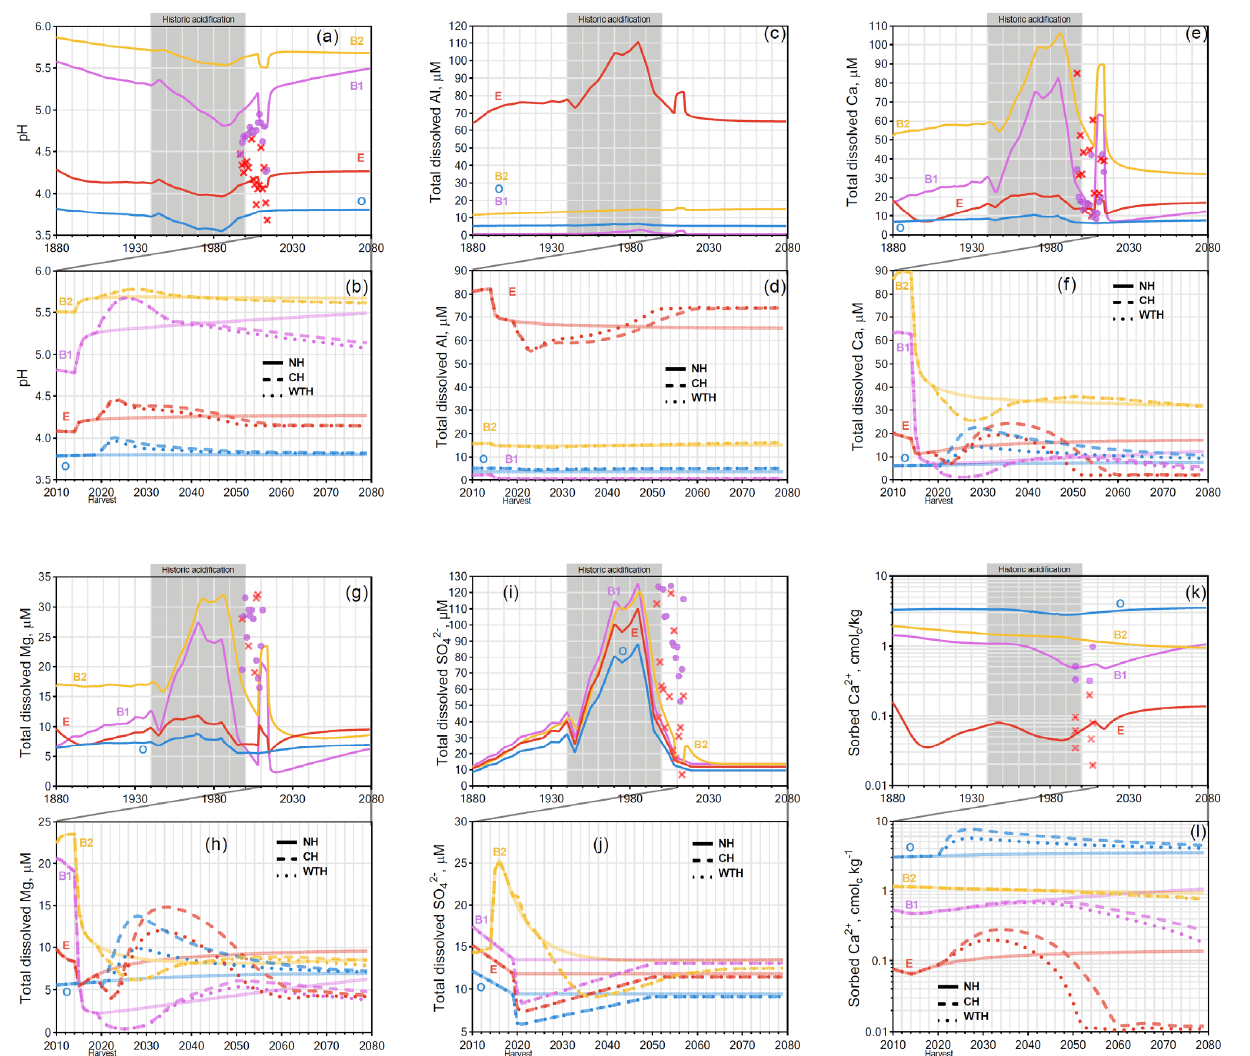
− (i, j) ; and sorbed 4